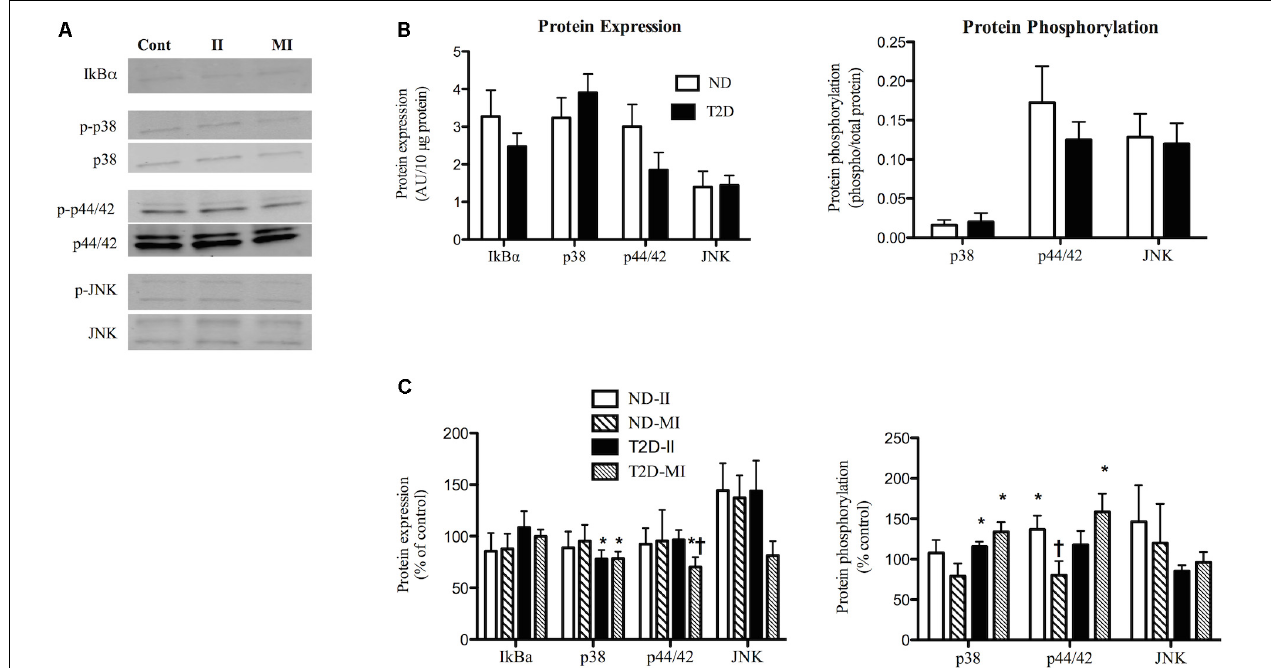
FIGURE 4 | Effects of II and MI conditions on markers of inflammatory signaling in ND- and T2D-MT. (A) Representative western blots for IkB α , total and phosphorylated p38, p44/42, and JNK after MT treated for 48 h. (B) Quantification of western blots under control conditions ( n = 10–13). (C) Quantification of western blots after treatment ( n = 10–13). Results presented as absolute value (B) or as a percentage of the appropriate control media (C) , Ave + SEM. Control = MT from the same individual w/o treatment. * p < 0.05 vs. matched control, † p < 0.05 vs. matched II.